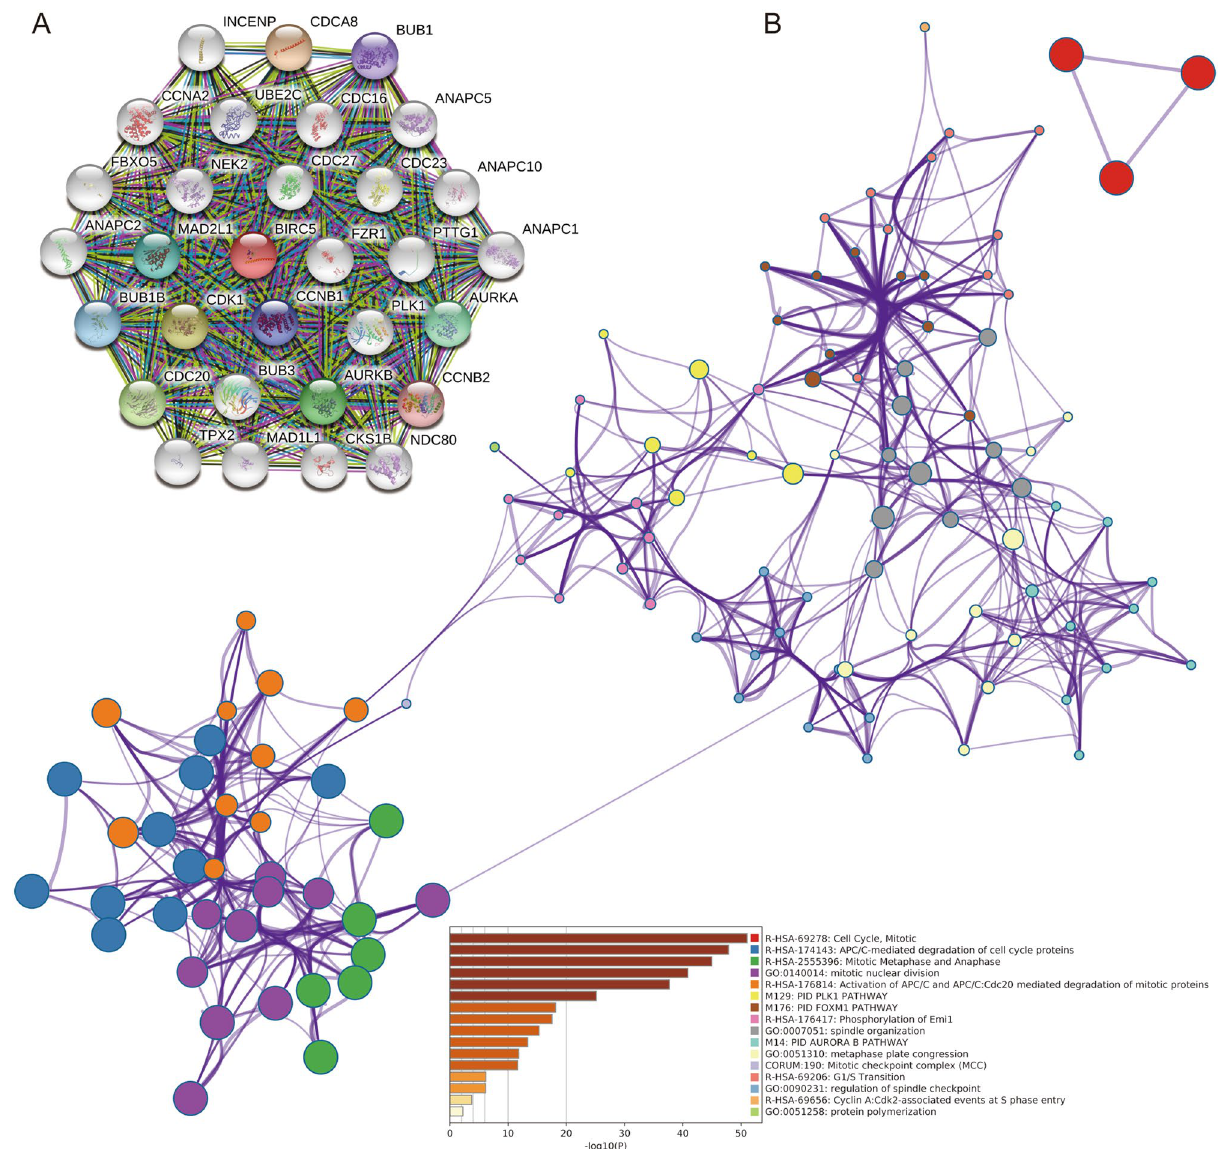
Figure 5. Potential molecular mechanisms and functional enrichment analysis of BIRC5. ( A ) The PPI network of BIRC5-related genes. ( B ) Functional enrichment Analysis based on BIRC5 interacting proteins. The figure was performed using R version 3.6.1 (2019-07-05) 46